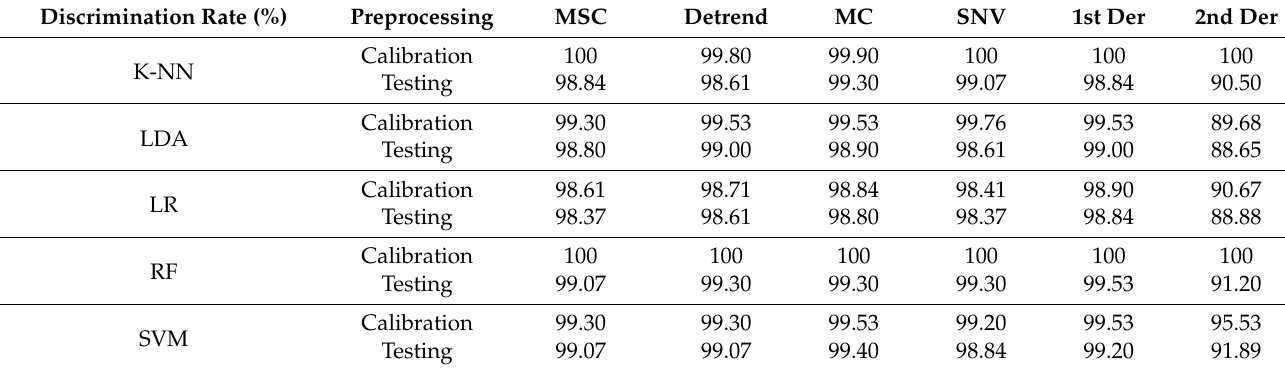
Table 2. Effect of preprocessing techniques on the five different